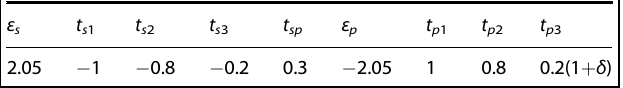
Fig. 3 The band structures and corner states of Ta 2 Ni 3 Te 5 monolayer. The orbital-resolved band structures of a d z 2 orbitals of Ta atoms, b d xz orbitals of Ni A atoms, and c p x orbitals of Te atoms. d The comparison between band structures of maximally localized Wannier functions and DFT results. e (01)-edge states around Γ . f The charge distribution of four corner states. The insert shows the energy spectrum of the Table 1. Parameters of the TB model for the QTI with chiral symmetry when δ = 0.